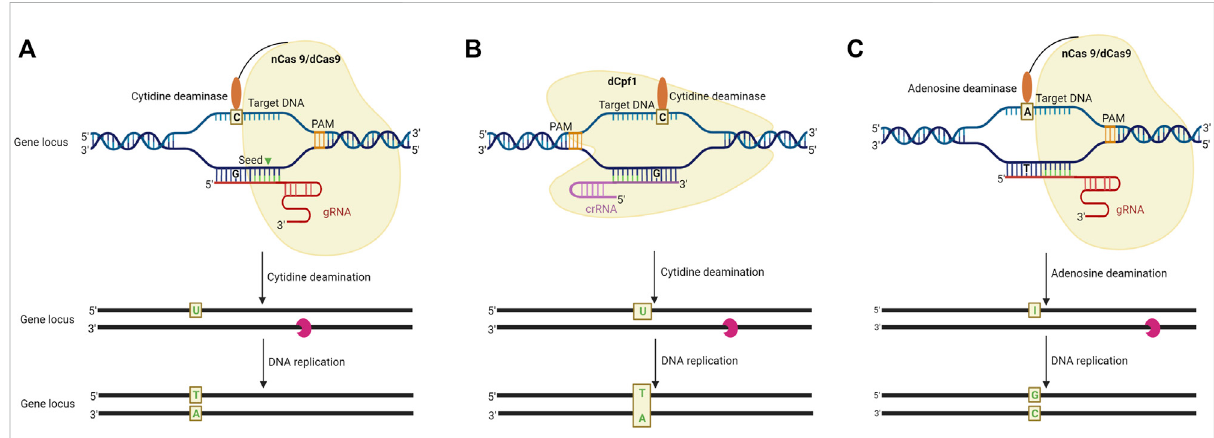
FIGURE 3 Schematic representation of base editing in plants by using DNA and RNA base editors. (A) . CRISPR/Cas9 system-mediated cytosine base editingsystem(CBE).AsgRNA-dCas9complexbindstotheintendedtargetsequencefollowingthiscytidinedeaminasecatalysesthedeaminationof cytosine (C) resultinginaC-GtoT-Aconversion. (B) CRISPR/Cpf-1mediatedCBEsystem.Inthissystem,dCpf1isfusedwithacytidinedeaminase,to make C-G to T-A conversion in the non-targeted DNA strand. (C) . CRISPR/Cas9-mediated adenine base editing system (ABE) employs